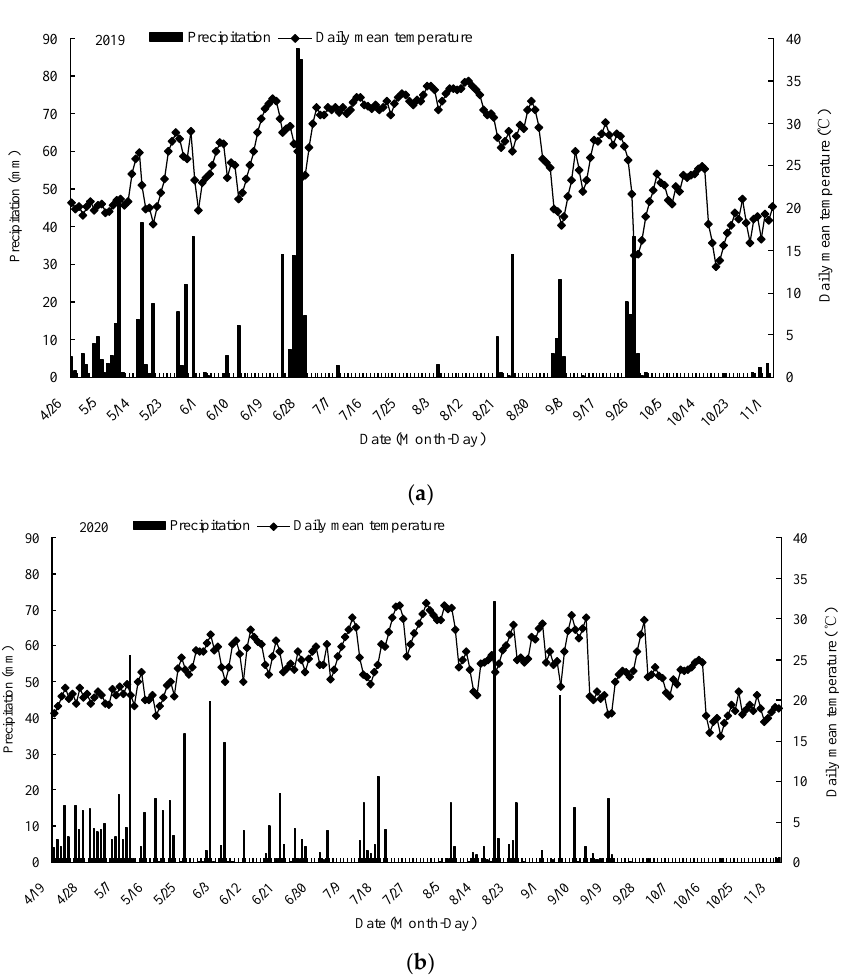
Figure 1. Daily precipitation and daily mean temperature of paddy field during experimental period. ( a ) was the 2019, ( b ) was the 2020.